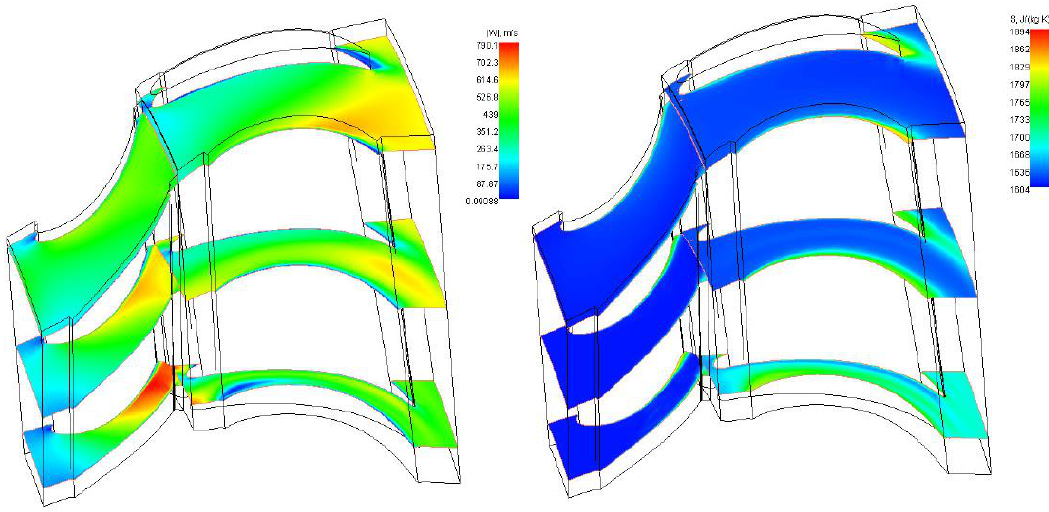
Figure 36. Velocity and entropy contours at the design point.